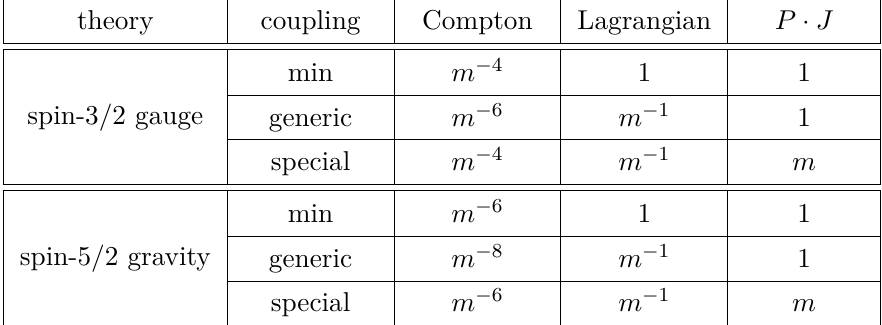
Table 1 . Details of the m → 0 scaling for the parallel cases of spin- 3 / 2 gauge theory and spin- 5 / 2 gravity. Minimal coupling is compared with generic or special non-minimal couplings linear in the field strength. The special theories satisfy the current constraint, with non-minimal couplings (5.9) and (5.50). Note that the longitudinal components of the polarizations dominate the behavior of the Compton